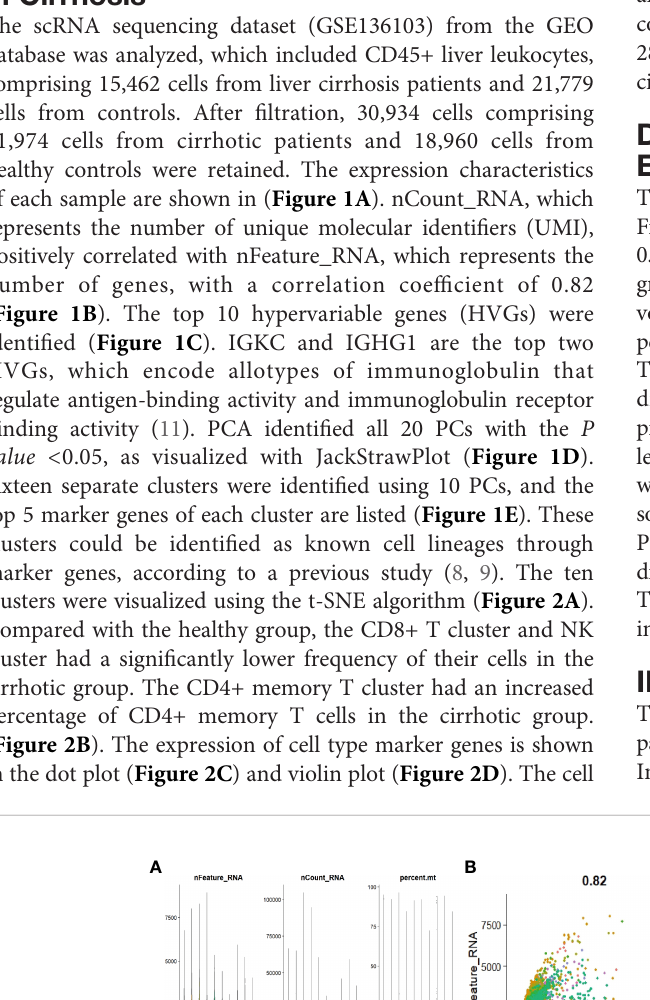
proportions of each cluster in two groups are shown in Figure 2E . The number and proportion of each cluster in each sample are shown in Figure 2F respectively. The CD8+ T cluster and NK cluster were signi fi cantly reduced in the cirrhotic group compared with the healthy group (11.6% vs. 36.4%, 15.7% vs. 28.7%), while the CD4+ T cells percentage was increased in the cirrhotic group (41.0% vs. 17.8%).